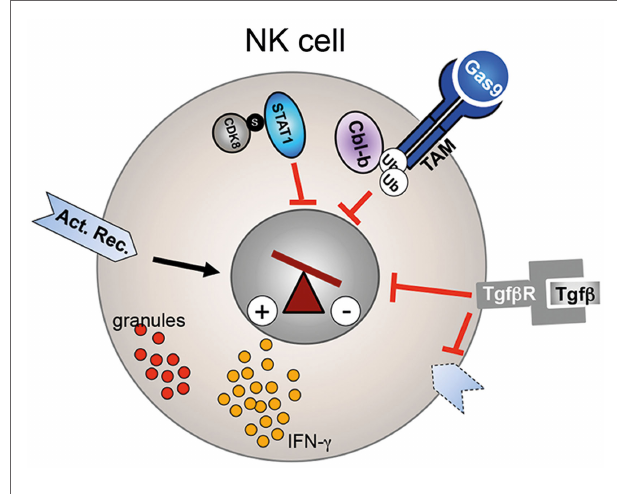
FiGURe 2 | Regulation of NK cell activity . CDK8-mediated STAT1–Ser727 phosphorylation inhibits the cytolytic activity of NK cells. Similarly, Cbl-b-mediated ubiquitinylation of the TAM receptor results in reduced perforin, granzyme B (red granules), and IFN- γ secretion. TGF- β signaling reduces as well NK cell effector function and leads to downregulation of activating receptors (dotted